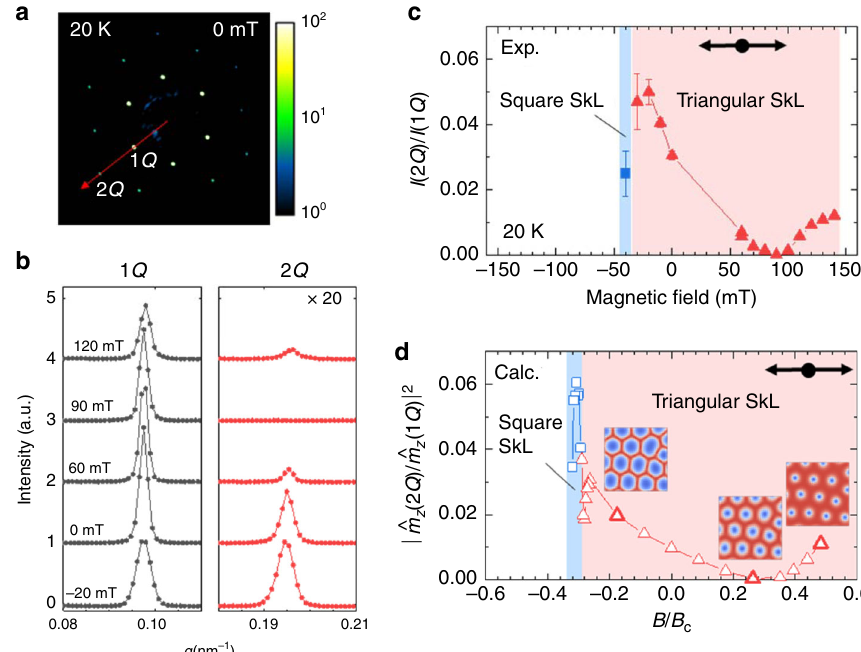
Fig. 4 Magnetic- fi eld dependence of anharmonicity in the SkL spin texture. a A RSXS diffraction pattern at 20 K for the metastable triangular SkL state at zero fi eld after fi eld cooling (Path 1). b The line-scan pro fi le of scattering intensity for the fundamental (1 Q ) and the second-order harmonic (2 Q ) re fl ections along the red arrow in a . c Magnetic fi eld dependence of the 2 Q intensity ( I (2 Q )) normalized by the 1 Q one ( I (1 Q )). The diffraction intensity is integrated so as to encompass the diffraction spots. Similar behavior has also been con fi rmed for other line-scan directions. d Magnetic fi eld dependence of j ^ m ð 2 Q Þ = ^ m ð 1 Q Þj 2 calculated from the results of micromagnetic simulations. The spin texture for the selected B -value (highlighted by bold triangular z z symbols) are also shown in the inset. Black arrows indicate the direction of fi eld